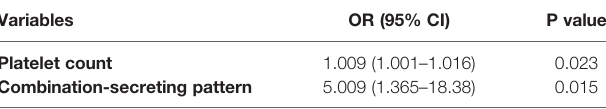
TABLE 4 | Multivariate logistic regression analysis of risk factors for CCs among patients with PPGL.